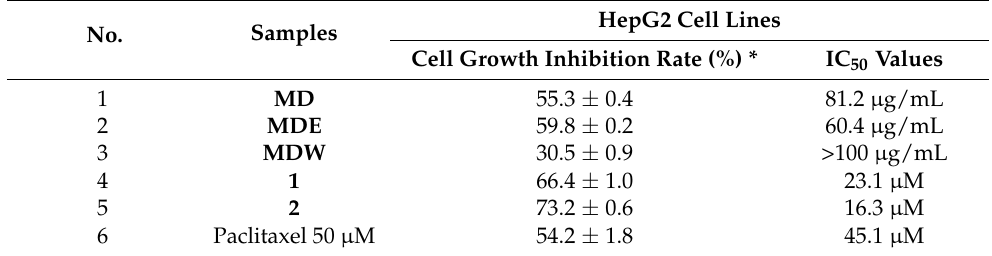
Table 3. Test results of in vitro cytotoxicity of crude extract, fractions, and compounds ( 1 and 2 ). No.